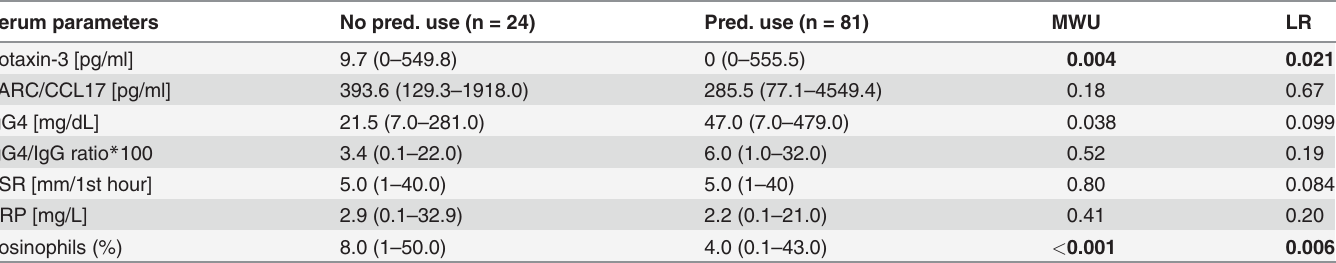
Table 3. Serum biomarkers of patients with EGPA based on prednisone usage at time of study visit. Serum parameters